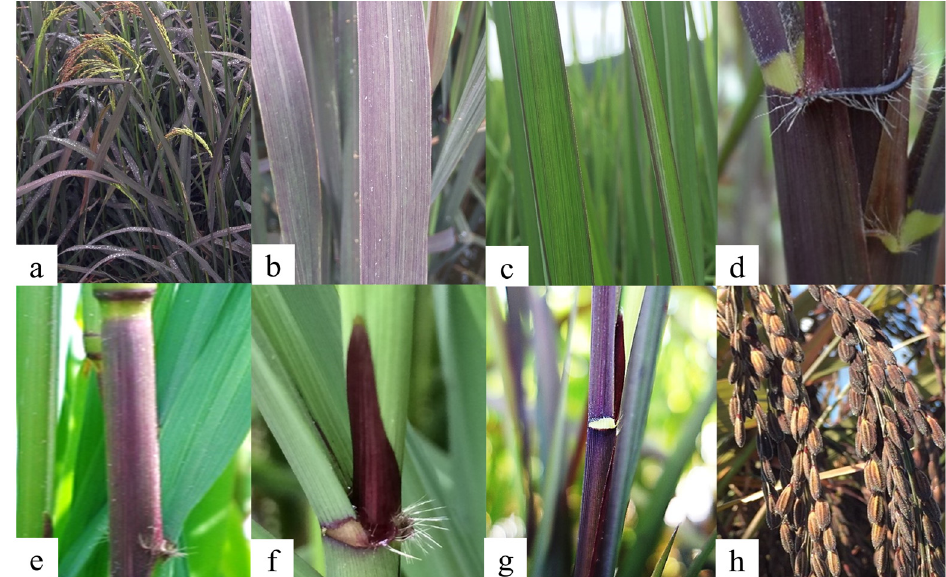
Figure 4. Anthocyanin pigmentation in the different plant parts. ( a ) Whole rice plant, ( b ) fully purple leaf blade, ( c ) margin purple leaf blade, ( d ) auricle, ( e ) node and internode, ( f ) ligule, ( g ) leaf sheath and ( h ) husk.